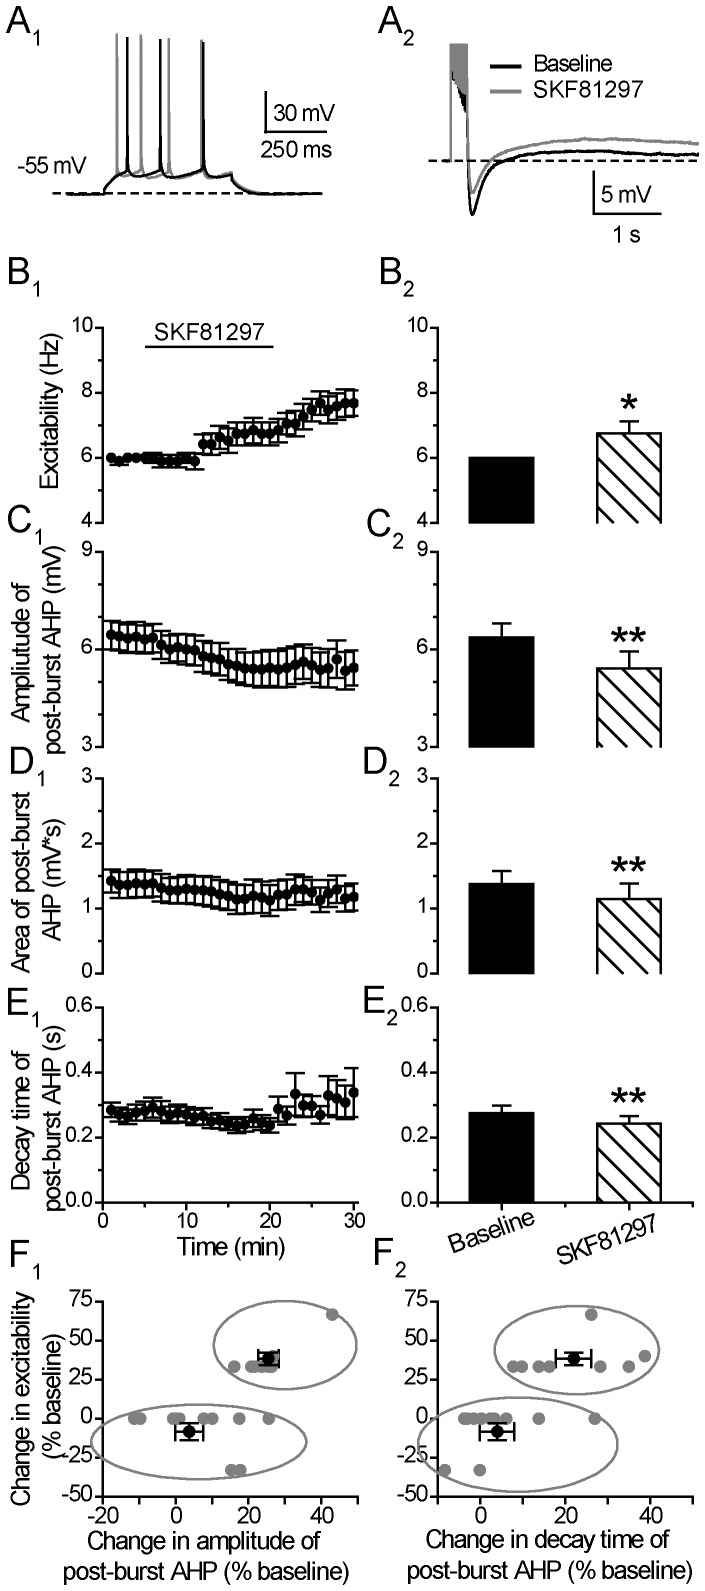
D1/5 stimulation enhances neuronal excitability and suppresses post-burst AHP.(A) An example of the effect of D1/5 receptor agonist SKF81297 (10 µM) on neuronal excitability (left) and post-burst AHP (right). The protocols for excitability test and post-burst AHP recording were run alternately every 30 seconds. (B) Excitability before, during and after 15-min application of the D1/5 receptor agonist SKF81297 (left). Group histograms showing that SKF81297 enhances the neuronal excitability of mPFC neurons (right) (*p<0.05 for SKF81297 vs. baseline, paired t-test). (C) Amplitude of post-burst AHP before, during and after 15-min application of SKF81297 (left). Group histograms showing that SKF81297 reduces the amplitude of post-burst AHP (right) (**p<0.01 for SKF81297 vs. baseline, paired t-test). (D) Area of post-burst AHP before, during and after 15-min application of SKF81297 (left). Group histograms showing that SKF81297 reduces the area of post-burst AHP (right) (**p<0.01 for SKF81297 vs. baseline, paired t-test). (E) Decay time of post-burst AHP before, during and after a 15-min application of SKF81297 (left). Group histograms showing that SKF81297 reduces the decay time of post-burst AHP (right) (**p<0.01 for SKF81297 vs. baseline, paired t-test). (F) Correlation plot showing two potential clusters of neurons with distinct response of excitability to the application of SKF81297. Mean±SEM of the two groups were displayed as black symbols. In a few cells, the negative values in the X-axis mean an increase in post-burst AHP.